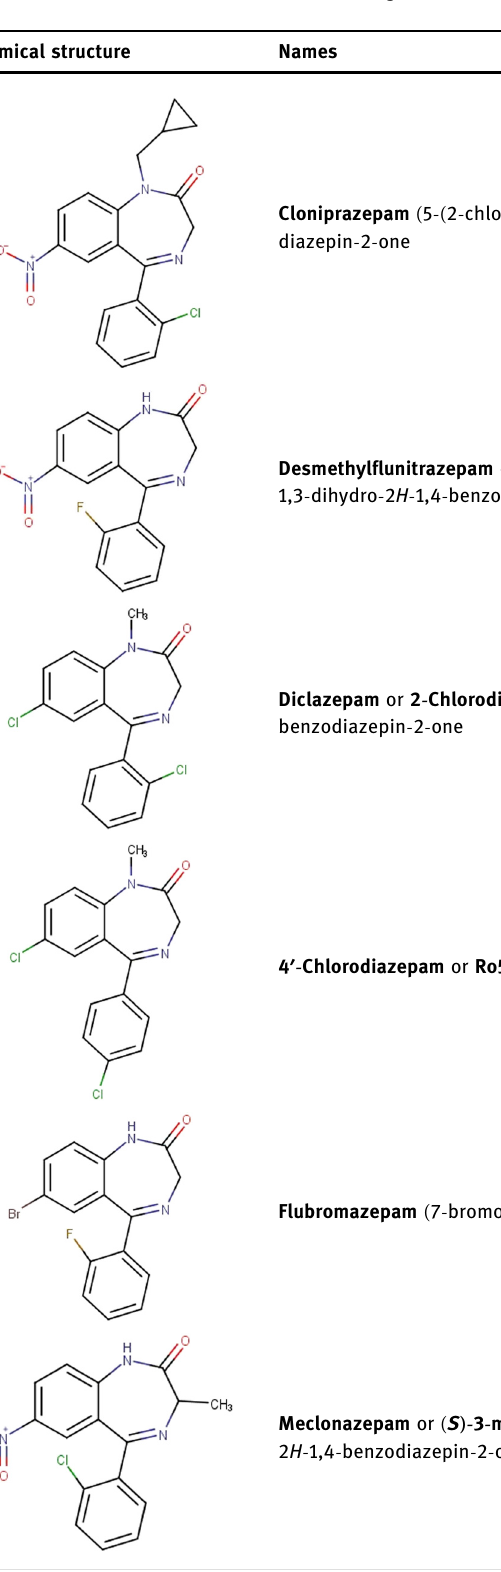
Table 4: Chemical structures and names of designer benzodiazepines [ 455 ]